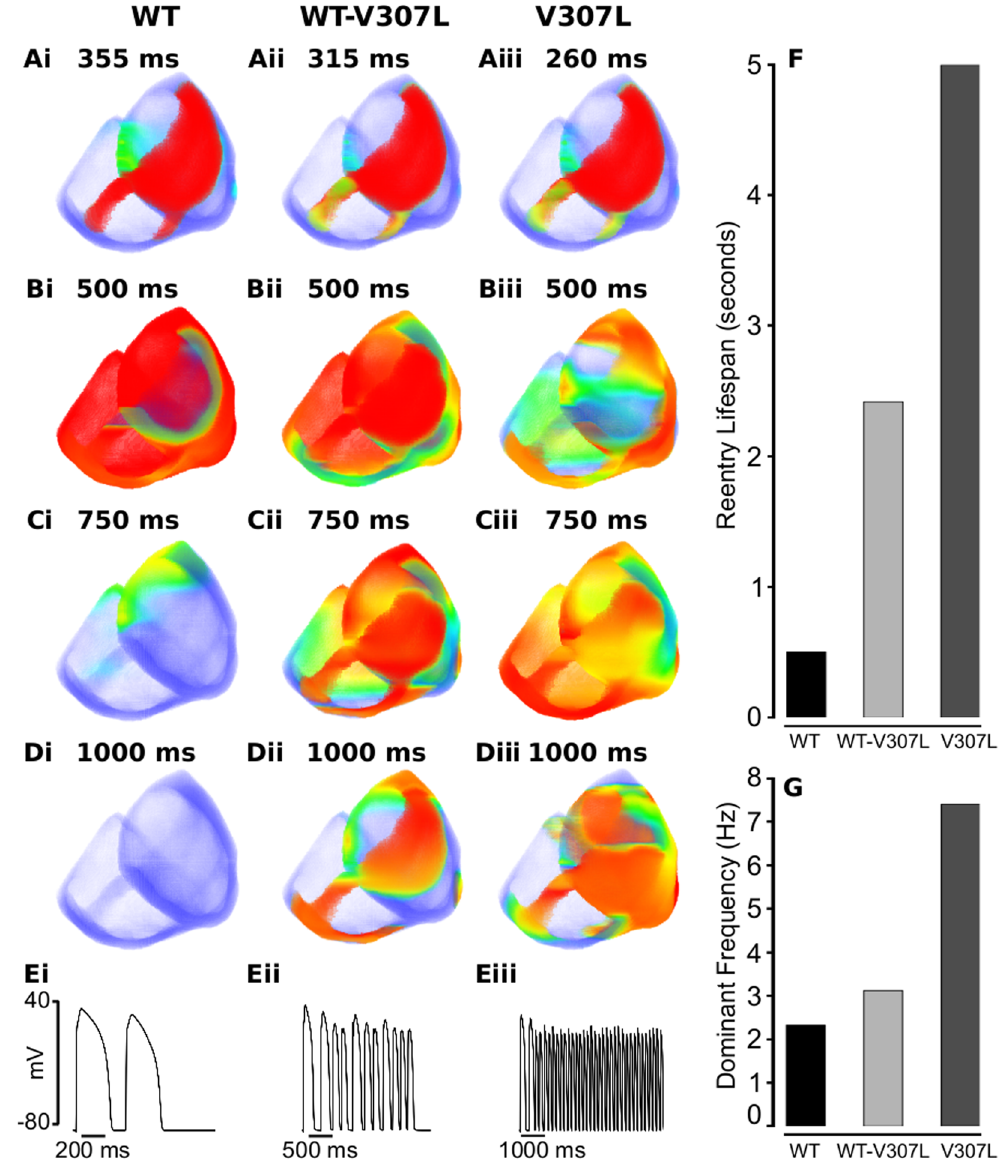
Figure 6. Snapshots of re-entry in 3D anatomical model of ventricles. ( A ) Application of a premature S2 stimulus in a local region during the refractory period of a previous excitation wave after a time delay of 355 ms for WT (i), 315 ms for WT-V307L (ii), and 260 ms for V307L (iii) conditions. Snapshots of developed scroll waves at time, t = 500 ms ( B ), t = 750 ms ( C ), and t = 1000 ms ( D ) in WT (i), WT-V307L (ii), and V307L (iii) conditions. ( E ) Time series of cellular APs recorded in the left ventricle in WT (i), WT-V307L (ii), and V307L (iii) conditions. Measured lifespan ( F ) and dominant frequency ( G ) of re-entrant spiral waves. Computed dominant frequencies of electrical activity recorded in the left ventricle are 2.34 Hz, 3.13 Hz, and 7.42 Hz for WT, WT-V307L, and V307L conditions,